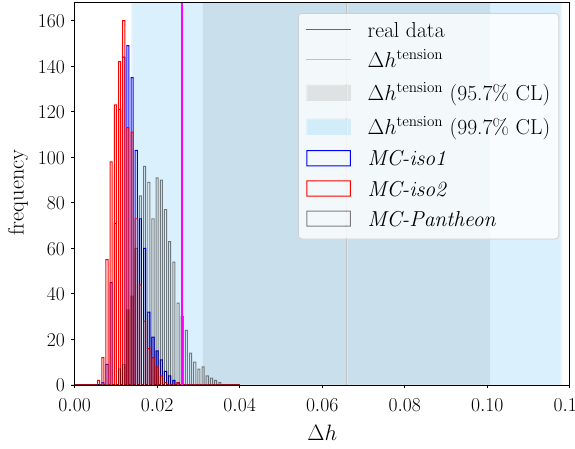
Fig. 2 The (cid:6) h of all MC realizations compared to the value obtained from the real data (pink vertical line), as well as the (cid:6) h tension at 1 and 2 σ C.L. displayed in light gray and blue shades,